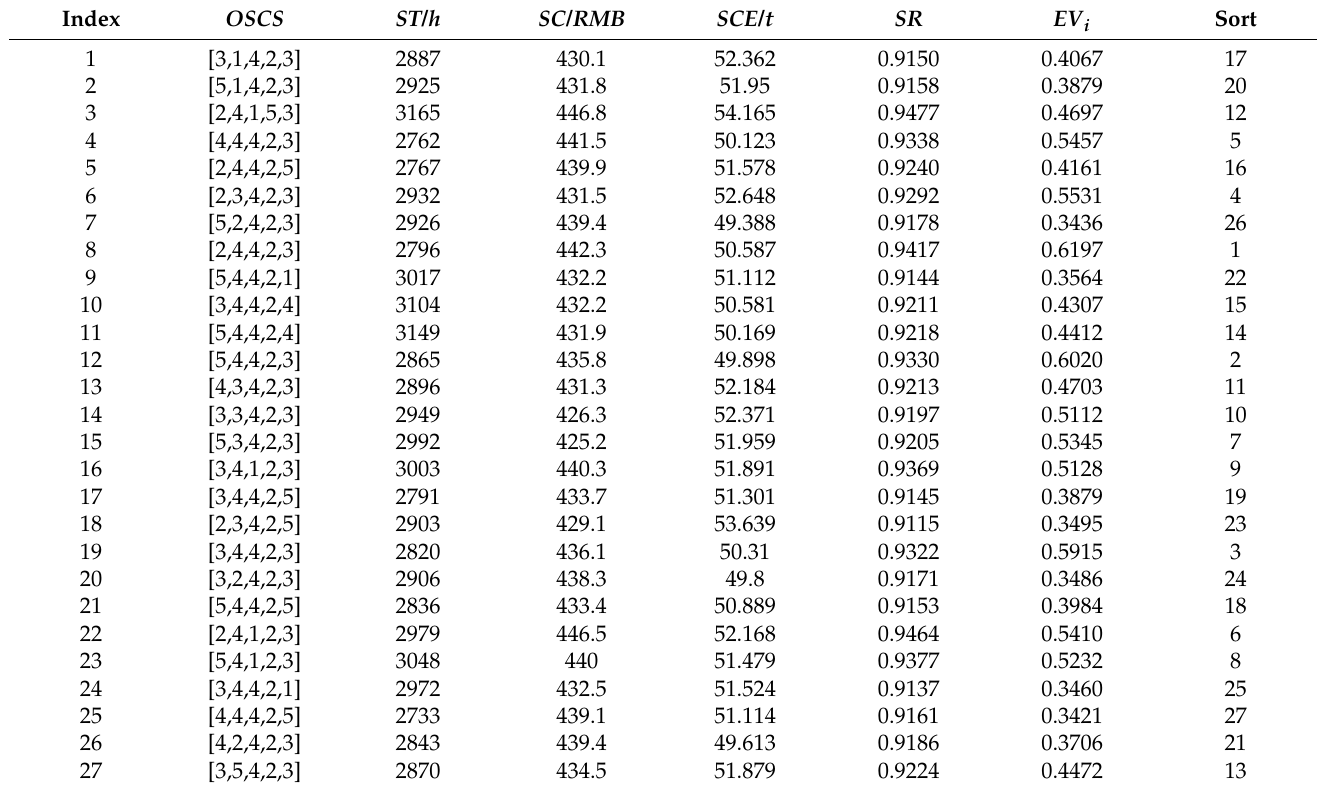
Table 6. The candidate outsourcing service composition schemes.